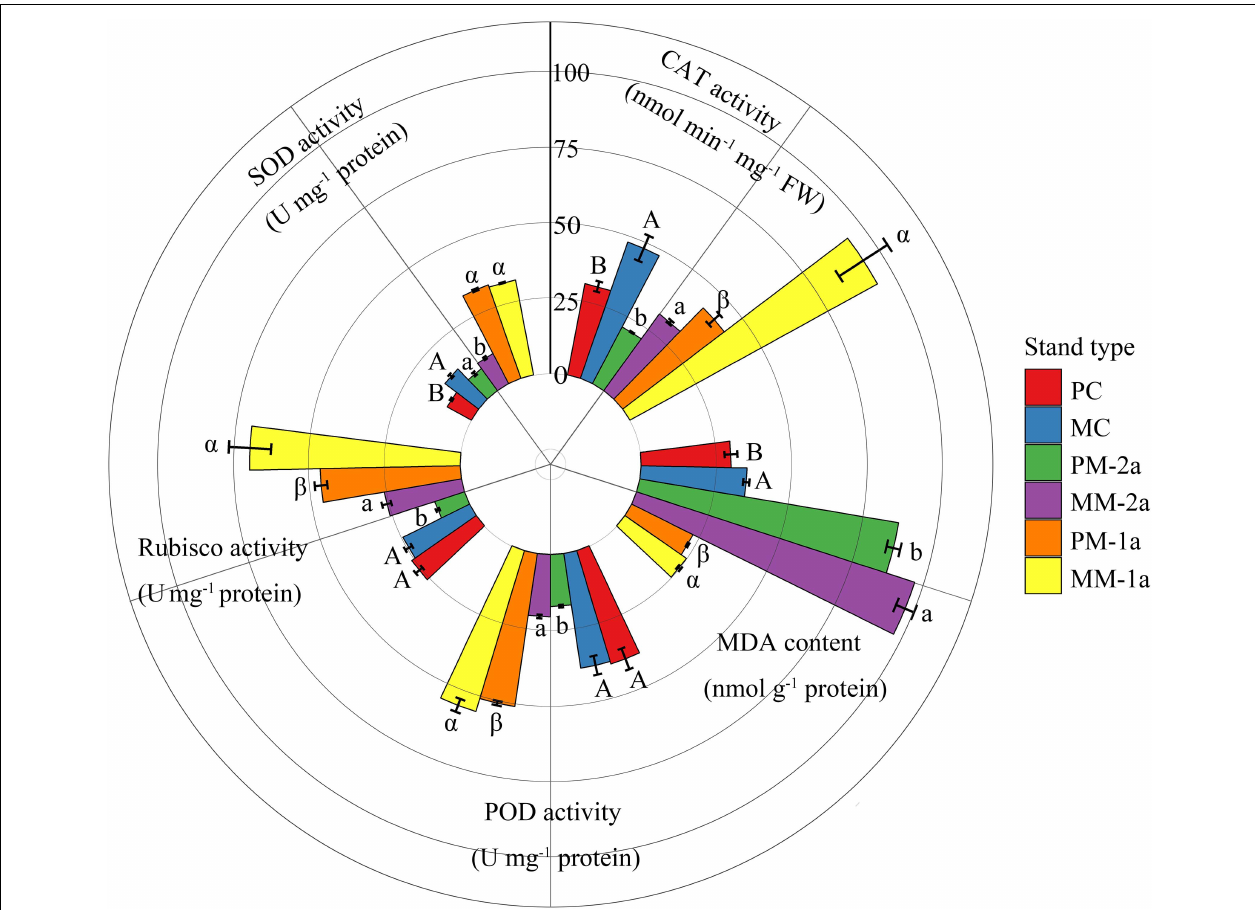
FIGURE 4 | Antioxidant enzyme activities, Rubisco activity, and malondialdehyde (MDA) content in moso bamboo and Chinese fir leaves in different stand types. Capital letters indicate significant differences between Chinese fir under monoculture (PC) and mixed-stand (PM) conditions ( P < 0.05). Lowercase letters indicate significant differences between 2-year-old moso bamboo under monoculture (PM-2a) and mixed-stand (MM-2a) conditions ( P < 0.05). Greek letters indicate significant differences between 1-year-old (1a) moso bamboo under monoculture (PM-1a) and mixed-stand (MM-1a) conditions ( P < 0.05). SOD: superoxide dismutase; POD: peroxidase; CAT: